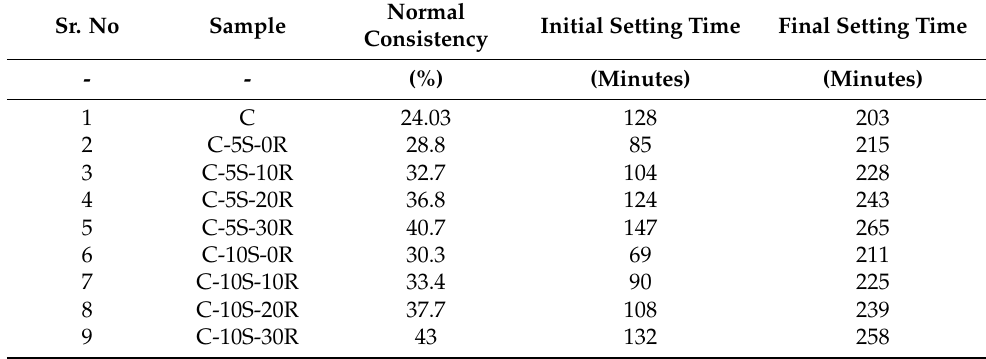
Table 6. Fresh Properties of